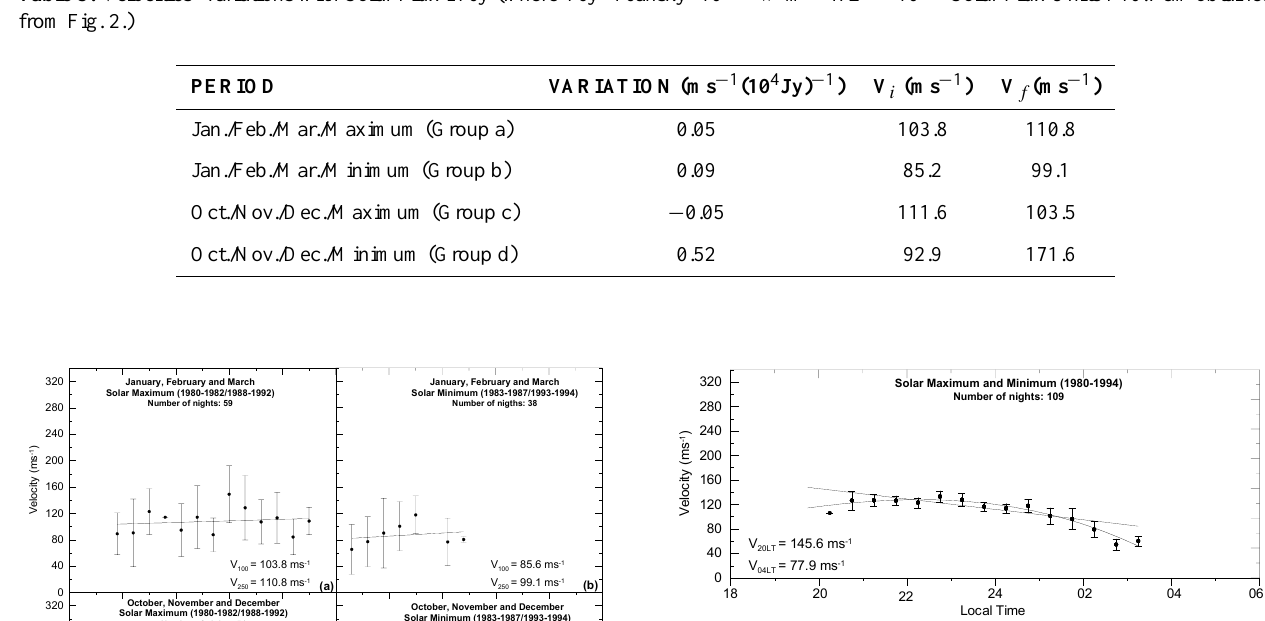
Figure 3. Plasma bubble zonal drift velocities (109 nights of experiments) versus the Local Time. Fig. 3. Plasma bubble zonal drift velocities (109 nights of experi- ments) versus the Local Time.